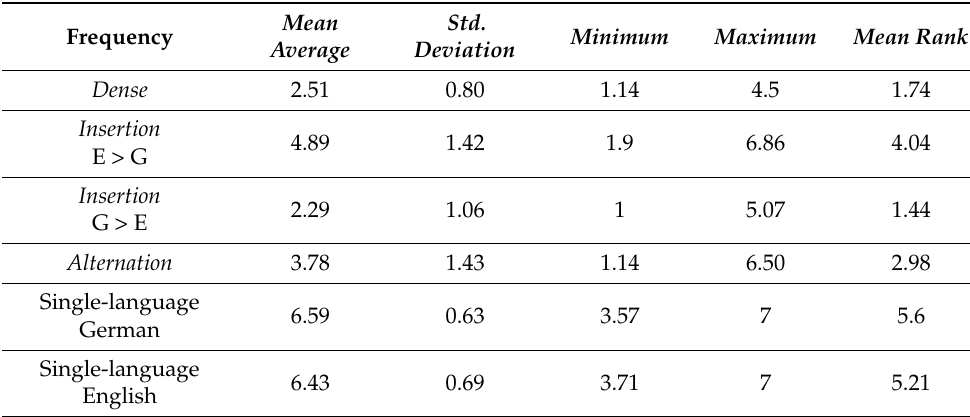
Table 3. Frequency scores from the judgement task (scale